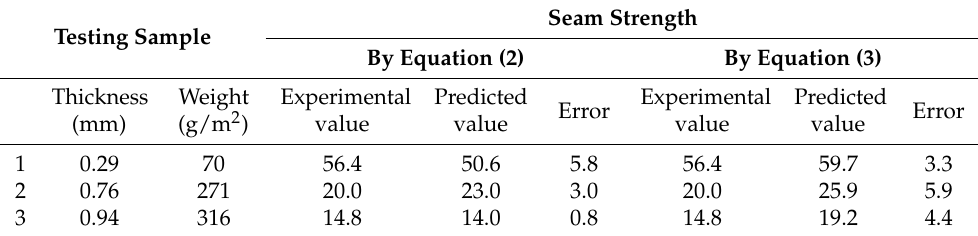
Table 10. Seam strength prediction result of regression model. Testing